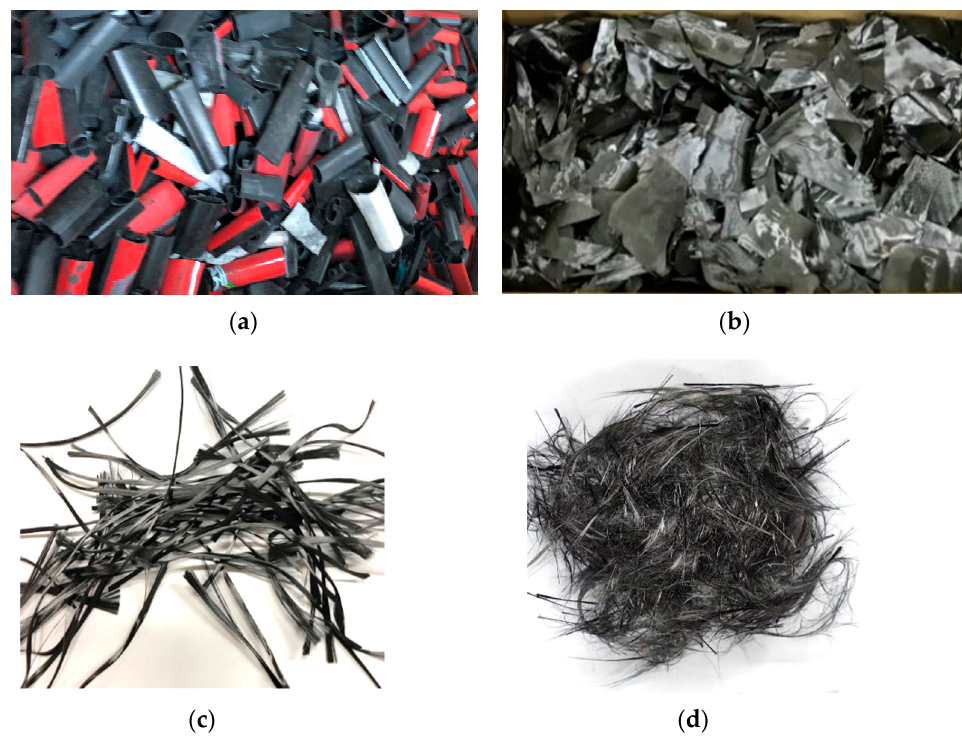
Figure 4. The procedure of carbon fiber recycling. ( a ) CFRP bicycle frame scrap before microwave- assisted pyrolysis; ( b ) microwave-assisted pyrolysis applied specimen; ( c ) recycled carbon fiber by cutting; ( d ) recycled carbon fiber dispersed by pneumatic dispersion.